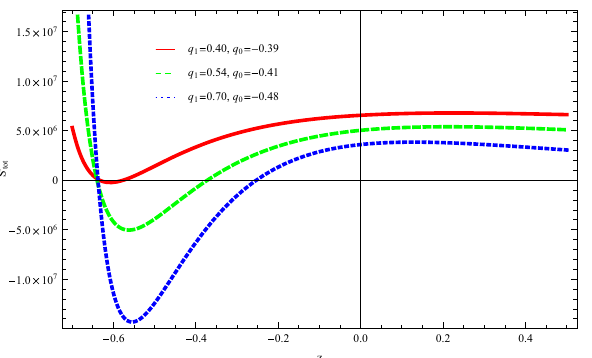
Fig. 5 Plotof w ef f versus z atHubblehorizonwithBekensteinentropy